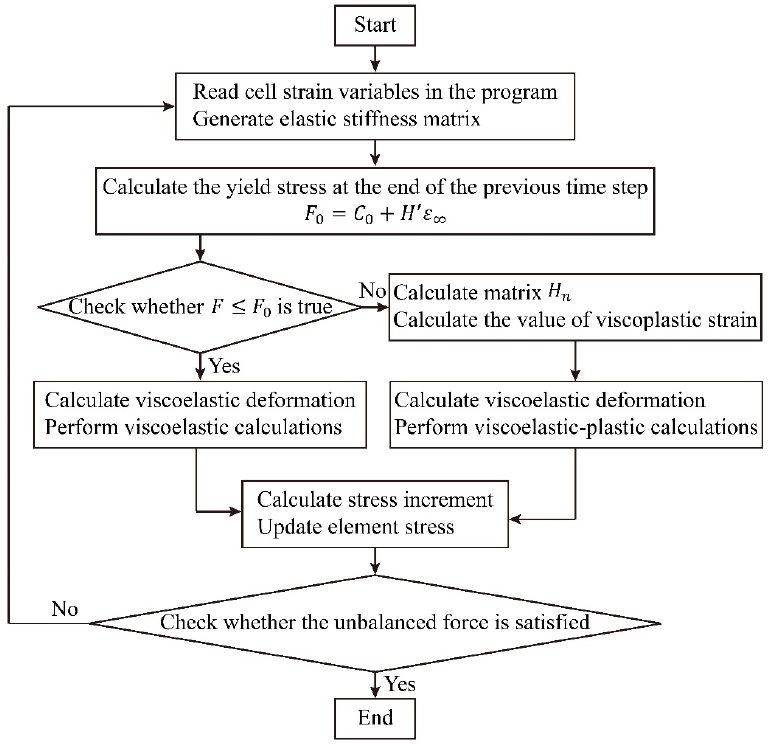
Figure 14. Flowchart of calculation program.